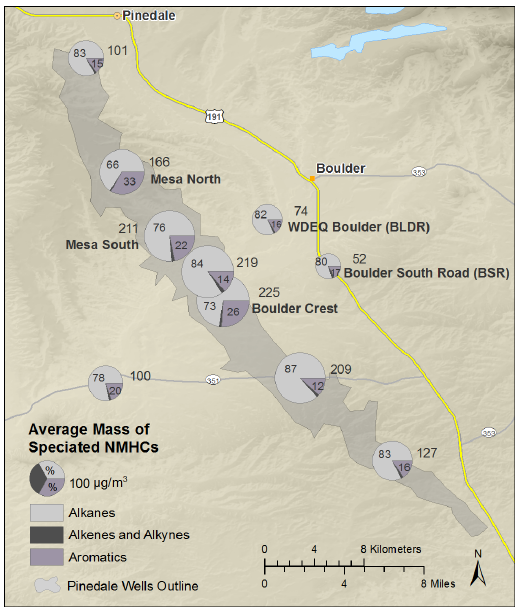
Figure 9. NMHC class distributions for 2011–2012 surveys at 10 sites within and around the Pinedale Anticline (Average mass are scaled as shown relative to the key value of 100µgm − 3